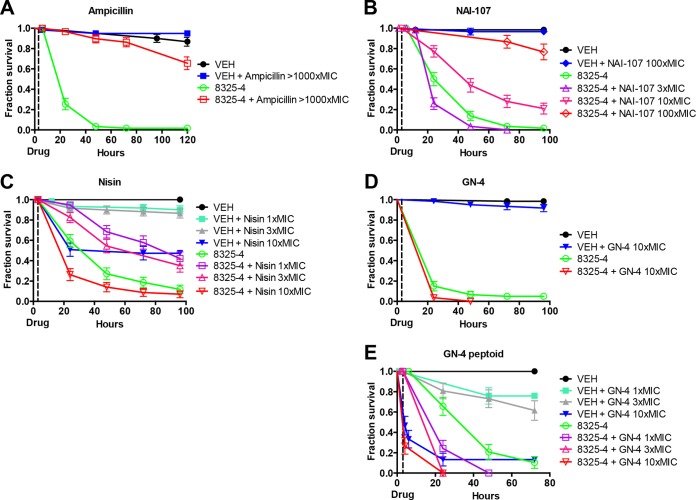
In vivo efficacies of compounds against S. aureus 8325-4 in a Drosophila whole-animal model. The graphs show the effects of different peptides and peptoids on survival of flies. (A) Ampicillin; (B) NAI-107; (C) nisin; (D) GN-4; (E) GN-4 peptoid. Flies were counted at 0, 3, 6, 12, 24, and 48 to 120 h. Flies were injected with either vehicle (VEH) or isolate 8325-4 at time zero, with the indicated treatments given at 3 h (dotted lines). Flies were counted prior to injection with compound. Compound concentrations are given as approximate concentrations in animals.